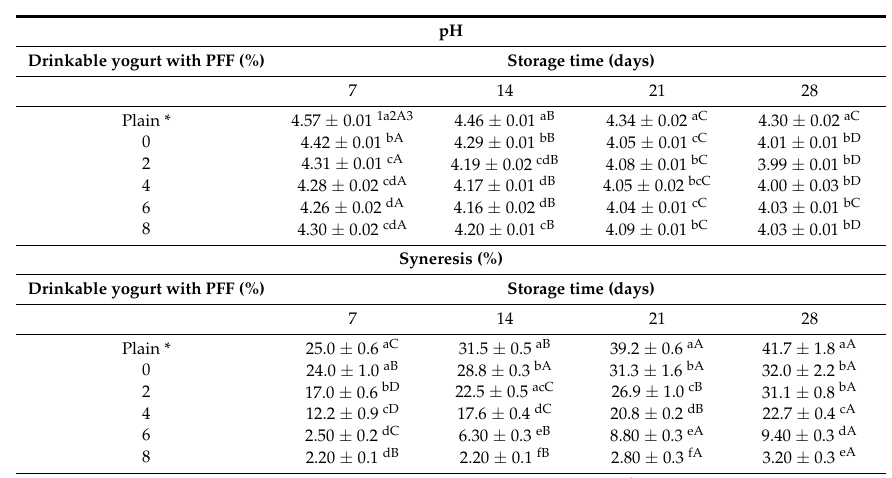
Table 2. Effect of passion fruit flour (PFF) addition on pH and syneresis of drinkable yogurts stored at 5 ◦ C for 7, 14, 21, and 28